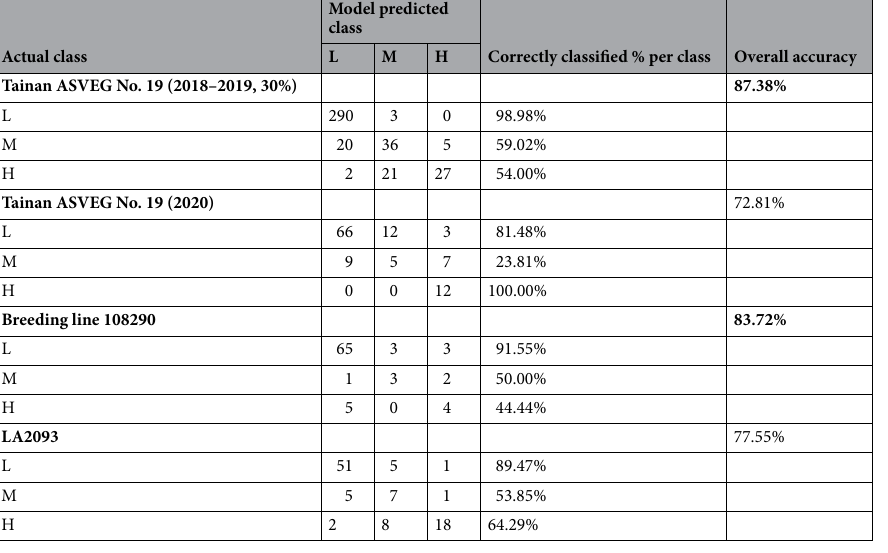
Table 5. Confusion matrix for the ordinal logistic model. Values that meet acceptable standards are shown in bold. L: low stress, with g sw ≧ 0.15 mol H 2 O m −2 s −1 ; M: medium stress, with 0.05 ≦ g sw < 0.15 mol H 2 O m −2 s −1 ;